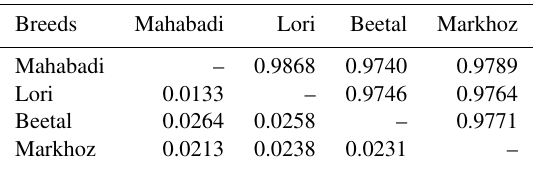
Table 4. Nei’s (1978) genetic identity (I, above diagonal) and ge- netic distance (D, below diagonal) among the four goat breeds.